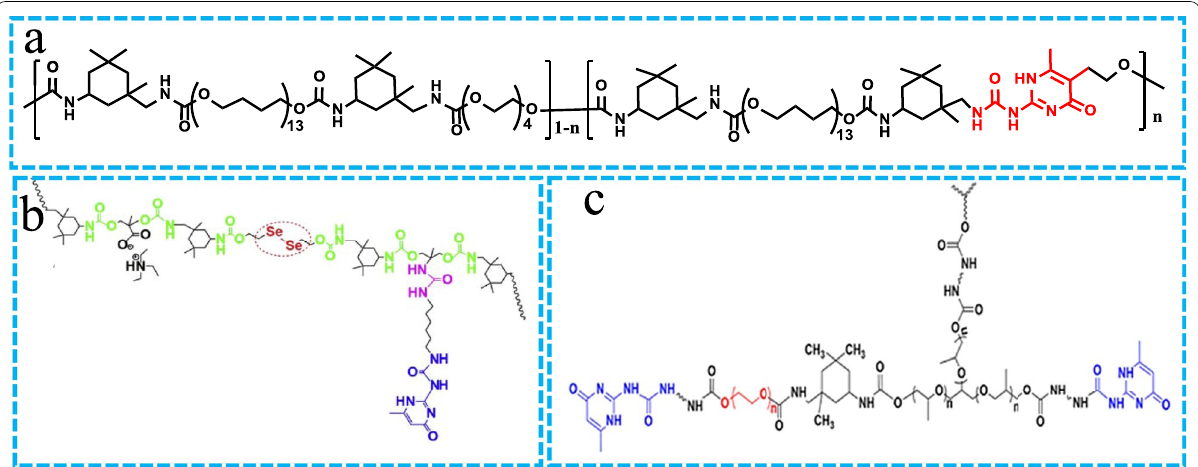
Fig. 9 Polyurethane structures containing UPy units in different positions: a Main chain. Reprinted with permission form Reference [70]. Copyright 2018, American Chemical Society. b Sidechain. Reprinted with permission form Reference [71]. Copyright 2020, Elsevier. c Chain end. Reprinted with permission form Reference [72]. Copyright 2019, American Chemical